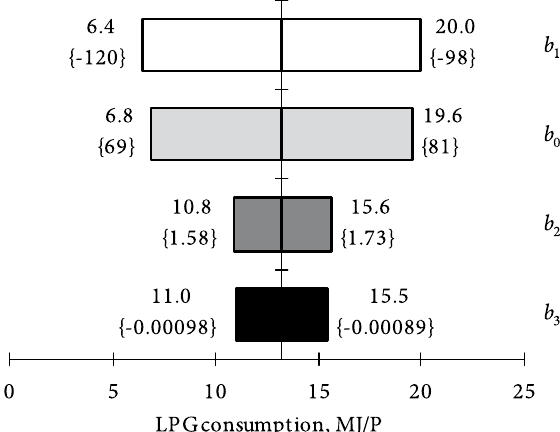
fig. 6. The sensitivity of equation (6) with confidence interval ±50% (Tornado